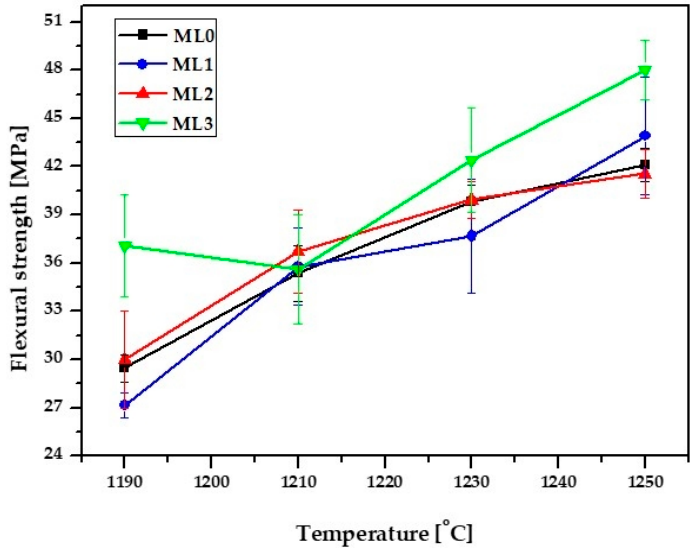
Figure 6. Flexural strength as a function of MWS waste amount and firing temperature.